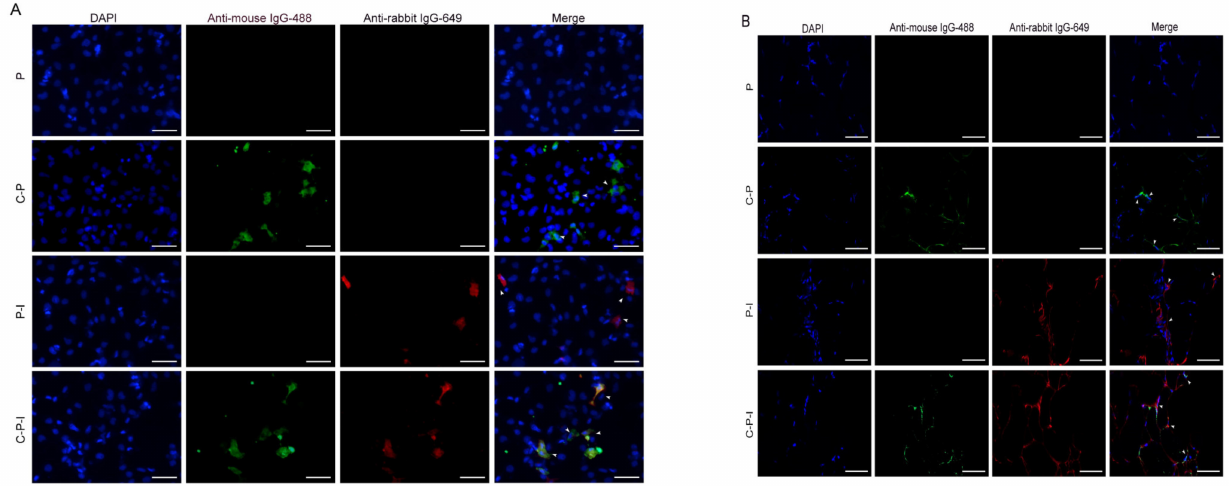
Figure 3. Expression of the bicistronic plasmids in vivo and in vitro. Protein expression in HINAE cells was analyzed by IFA 48 h after transfection ( A ). Muscles of fish five days after inoculation were cryosectioned (5 µ m, ( B )). Immunofluorescence labeling was performed by incubation with the mouse anti-NNV monoclonal antibody/rabbit anti-His polyclonal antibody and goat anti-mouse IgG-488/goat anti-rabbit IgG 649 to visualize the expression of CP and IRF3. The white arrow is the overlapped part of the fluorescent signal. Scale bar: 20 µ m. P: pBudCE4.1 group; P-I: pBudCE4.1-IRF3 group; C-P: CP-pBudCE4.1 group; C-P-I: CP-pBudCE4.1-IRF3